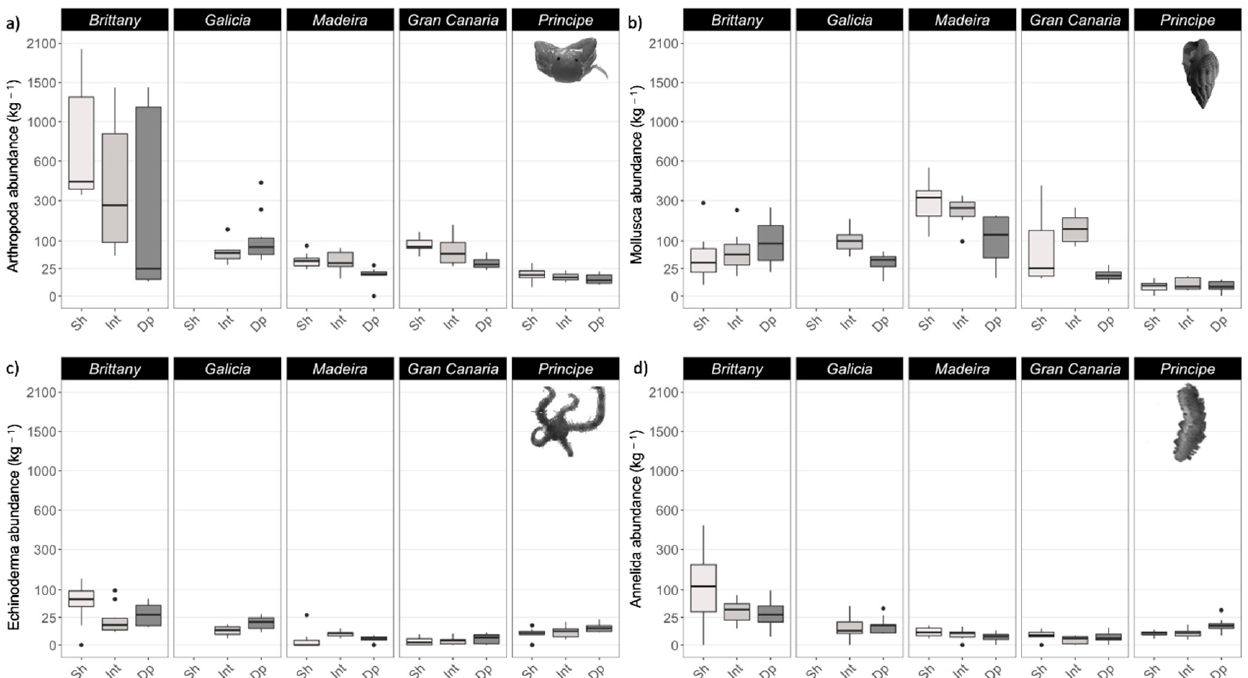
Figure 6. Faunal abundances (logarithmically transformed) at each region and depth strata (Sh: Shallow; Int: Intermediate and Dp: Deep), according to the four main phyla ( a ) Arthropoda, ( b ) Mollusca, ( c ) Echinodermata, and ( d ) Annelida.